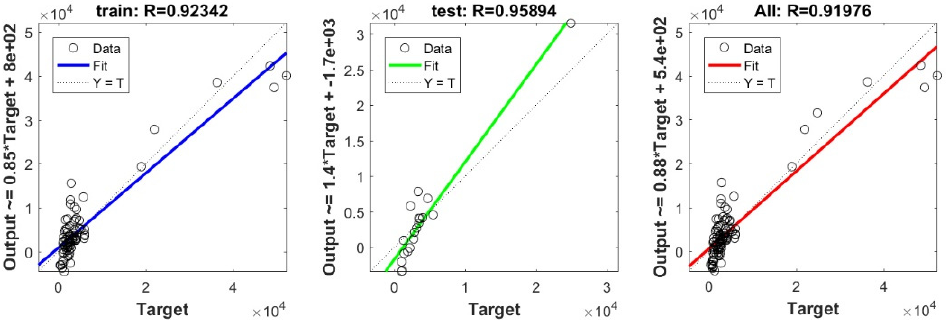
Figure A6. Scatter plots between target and output values by the LASSO model.